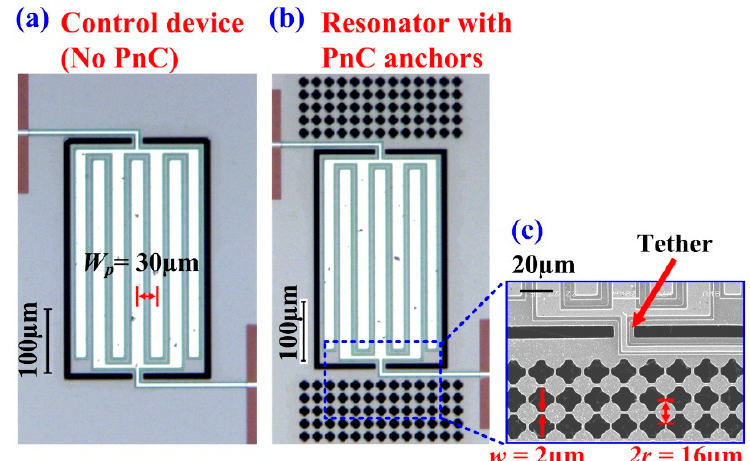
Figure 8. Optical micrographs of the fabricated devices: ( a ) Control device with no PnCs, ( b ) PnC bounded resonator, and ( c ) close-up view of the PnC matrix in relation to the Lamb mode resonator connected through the tether whose width was kept to the minimum allowed by the process.